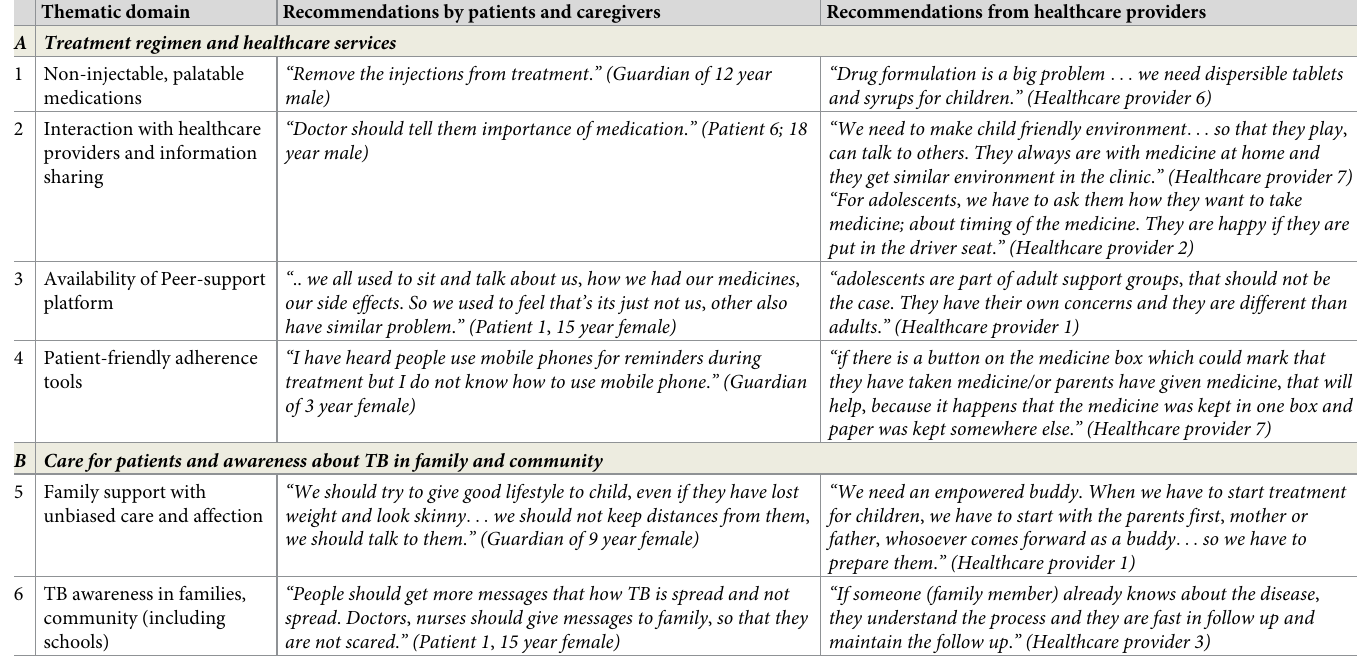
Table 1. Recommendations given by participants for developing child/adolescent-friendly care for patients during DR-TB treatment, Mumbai, India,